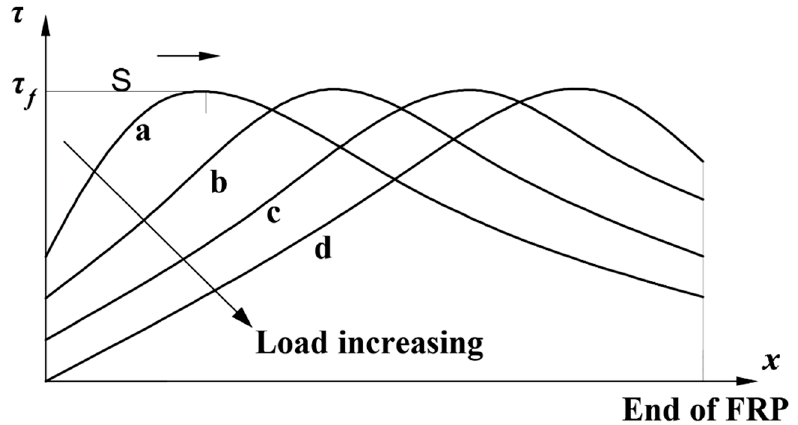
Figure 5. Interfacial shear stress changes at descending stage.